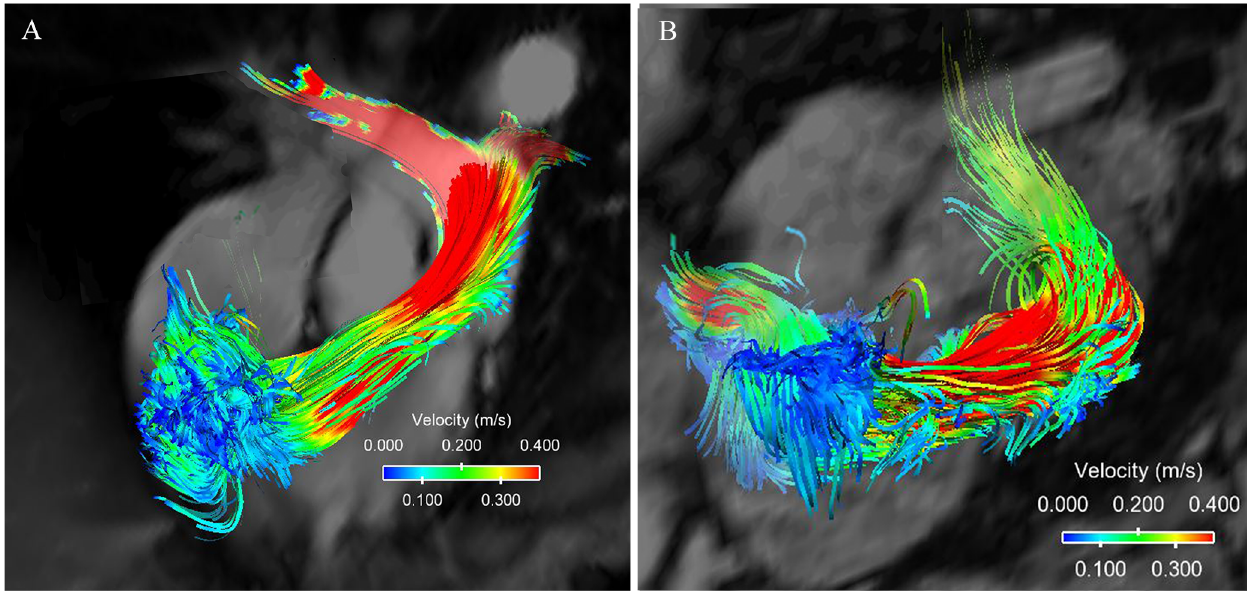
Fig 1. 4D flow patterns. (A) Flow pattern of a healthy subject in the right ventricle and the pulmolnary artery. The flow is laminar and is of relatively high velocity. (B) Flow pattern of a PAH patient with severe PA dilation where the vortices form in the PA and the flow velocities are